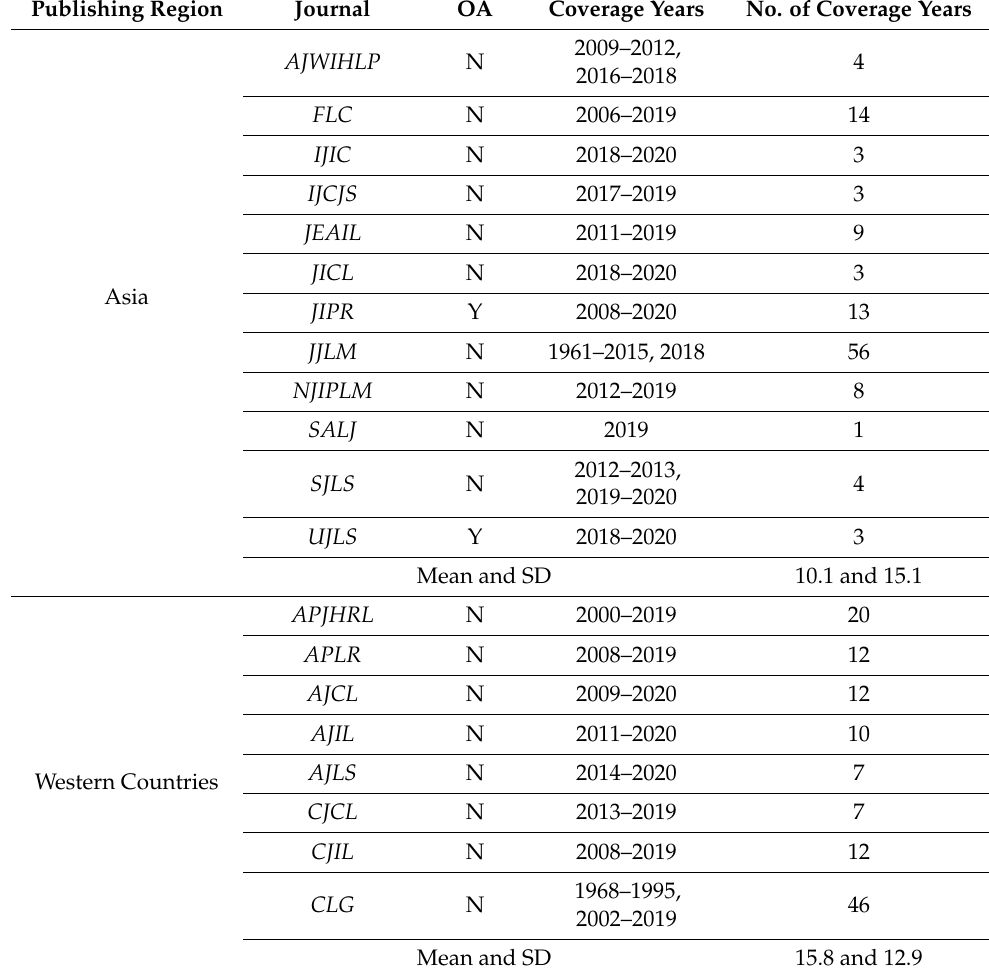
Table 2. Open Access Status and SJR Coverage